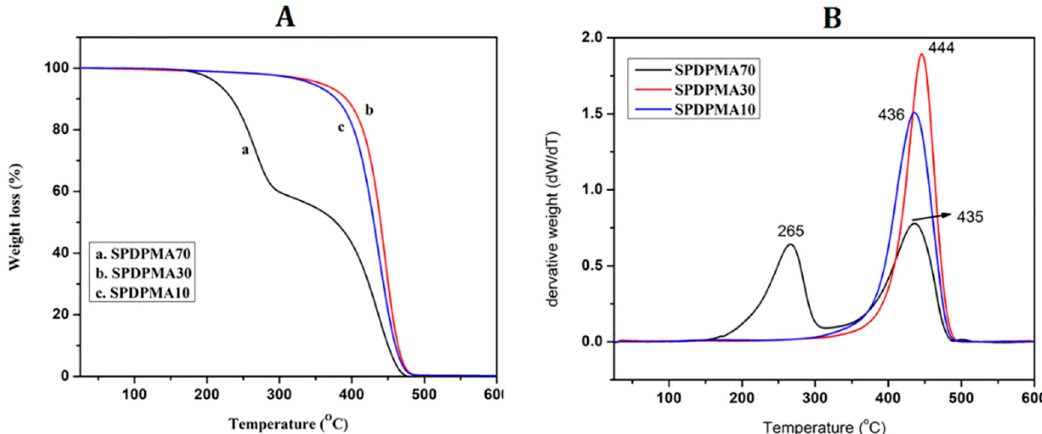
Figure 7. Thermal degradation properties of styrene-PDPMA copolymers ( A ) weight loss curve and ( B ) derivative plot.